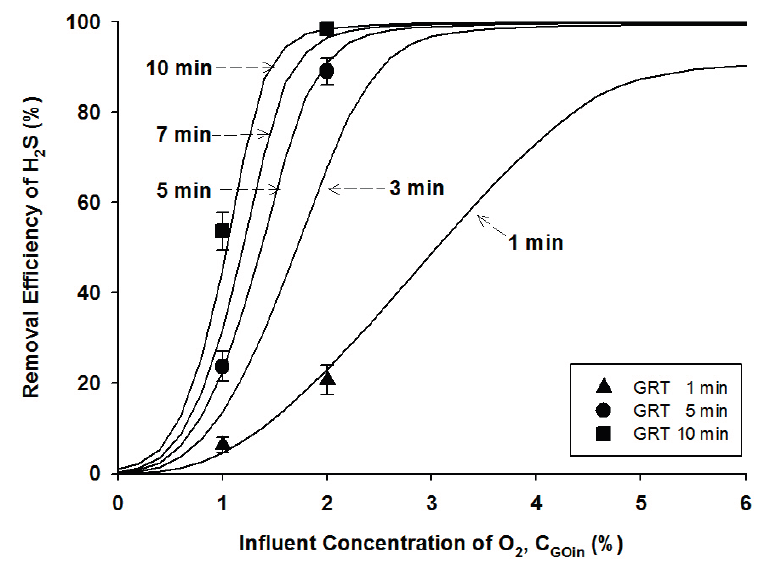
Figure 3. Experimental data (symbols) and model simulation results (lines) at different gas retention times as a function of the influent oxygen